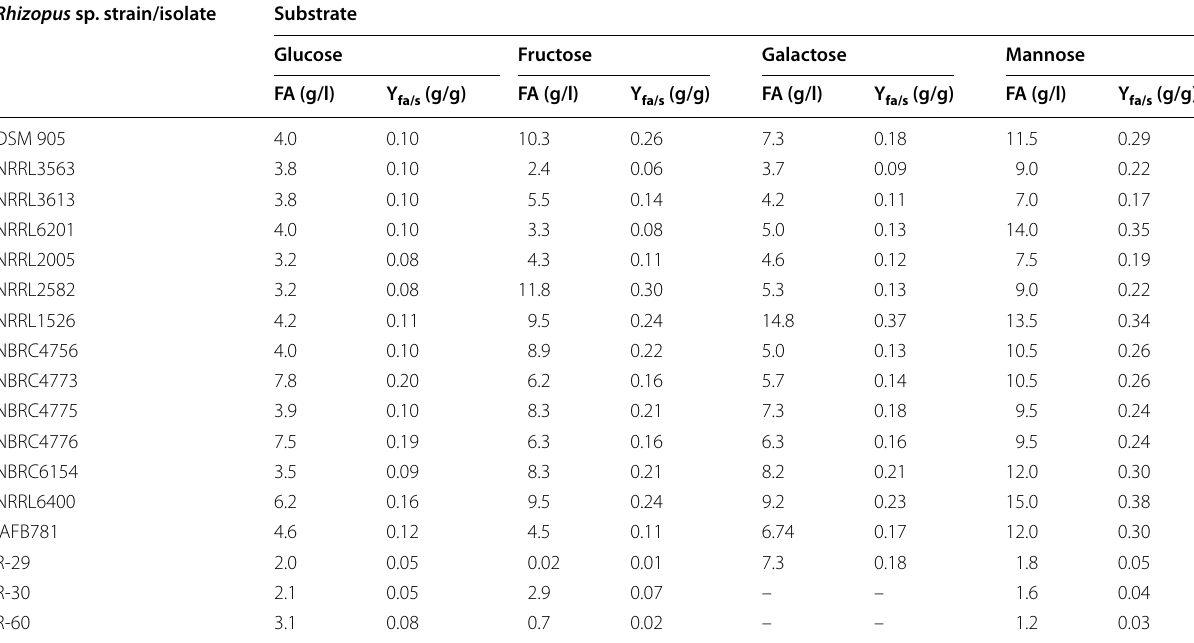
FA (g/l), fumaric acid concentration in medium after culture; Y fa/s (g/g), g of fumaric acid produced per g of carbon source consumed Table 3 Fumaric acid production from glycerol and xylose mixture by various strains of Rhizopus sp. after 120 h of growth (35 °C, 200 rpm) Rhizopus sp.